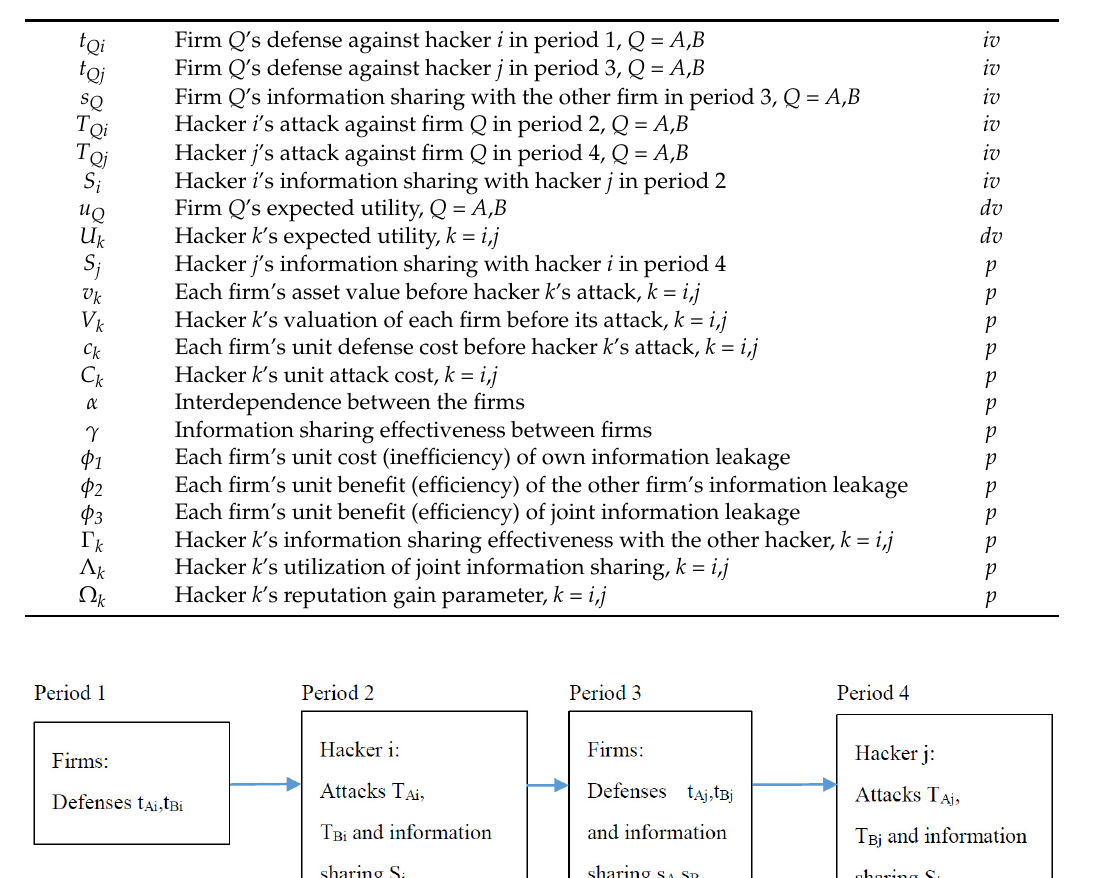
Figure 2. Interaction between two firms and between two hackers. In period 1 the firms have one strategic choice variable each which are their defenses t Ai and t Bi . The firms do not know which hacker attacks first, but prepare by defending against any hacker. In period 2 hacker i , which is the first hacker that happens to attack, has three strategic choice variables which are the attacks T Ai and T Bi and information sharing S i . Information S i is delivered by hacker i to hacker j in period 2. Hacker i chooses T Ai and T Bi before S i , using the attacks to gather information, but since the three choices are made in period 2, it is mathematically sufficient to state that T Ai , T Bi and S i are made in period 2. The firms’ defense efforts in period 1 last two periods, and thereafter have to be renewed. In period 3 the firms again have one strategic choice variable each which are their defenses t Aj and t Bj . In period 4 hacker j has two strategic choice variables which are the attacks T Ai and T Bi , and information S j is a parameter since the game ends after period 4. Hacker j uses the information S i from hacker i when exerting its attacks. In real life subsequent defense, attacks and information sharing occur after period 4, with S j as a free choice variable. However, considering more periods than the four in Figure 1 is beyond this paper’s scope. Each firm has an asset valued as v i before hacker i ’s attack, and valued as V i by hacker i . The firms invest t Ai and t Bi to defend their assets, with defense expenditures f Ai and f Bi , where